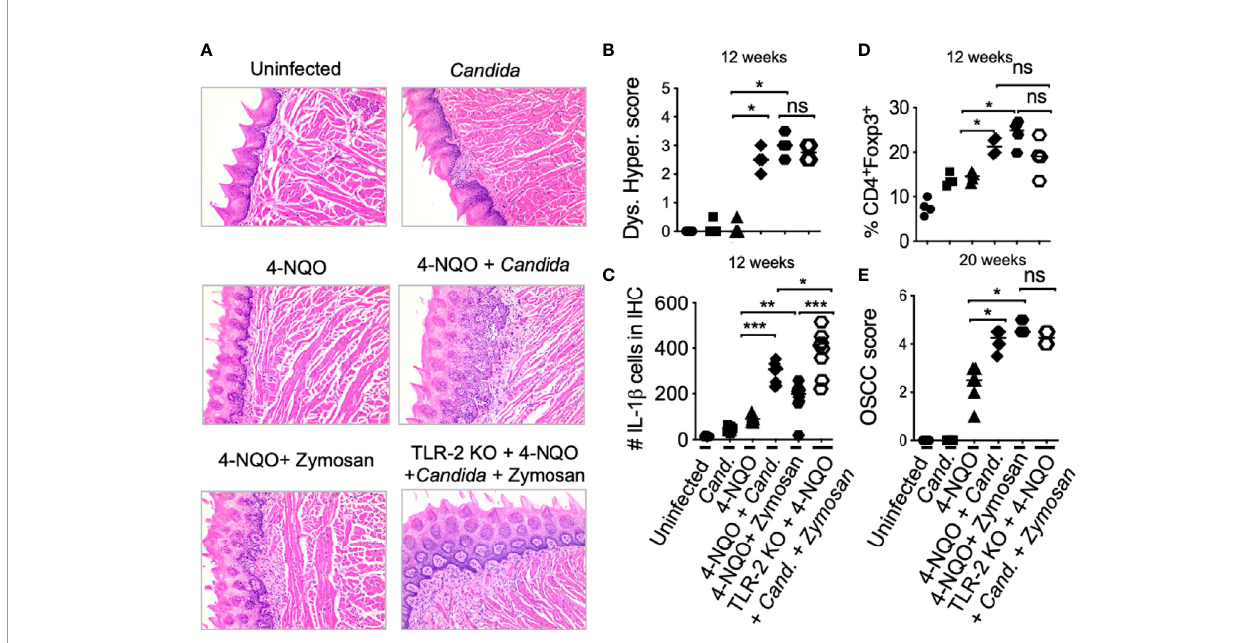
FIGURE 5 | Candida and Zymosan exacerbate and accelerate dysplasia and hyperplasia. (A) 4-NQO was administered in WT or TLR-2 KO C57BL/6 mice as in Figure 3A (6 mice/group). Zymosan (1mg), Candida (10 7 blastospores), or both were applied sublingually under anesthesia every week between the 4 th and 8 th weeks of 4-NQO administration. H&E staining was performed to assess dysplasia and hyperplasia (A) . Immunohistochemistry and fl ow cytometry were performed. Statistics based on dysplasia and hyperplasia score (B) , IL-1 b immunohistochemistry (C) , fl ow cytometry staining for T reg assessment (D) , and OSCC scores (E) . OSCC scores were assigned based on hyperplasia, invasive hyperkeratosis, and nests after 20 weeks after 4-NQO administration. Statistics show Mean +/- SEM (Mann-Whitney test *P < 0.05, **P < 0.05, ***P < 0.005, n.s, non-signi fi